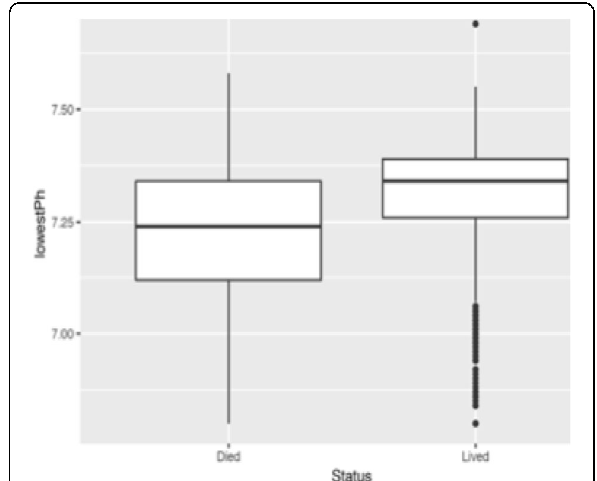
Fig. 1 (abstract 001355). Box Plot of lowest pH amongst Emergency Survivors and Non-Survivors